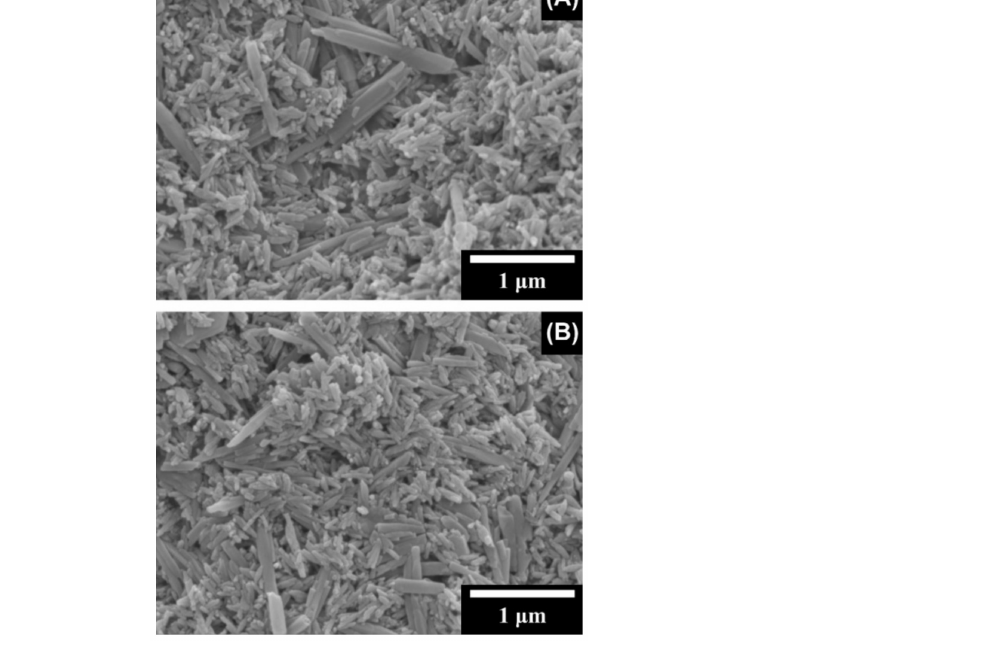
Figure 6. SEM images of composite films prepared by EPD from 1 g L − 1 HYNa solutions, containing 1 g L − 1 HAP and ( A ) 0.3 and ( B ) 0.6 g L − 1 halloysite nanotubes. Reproduced with permission